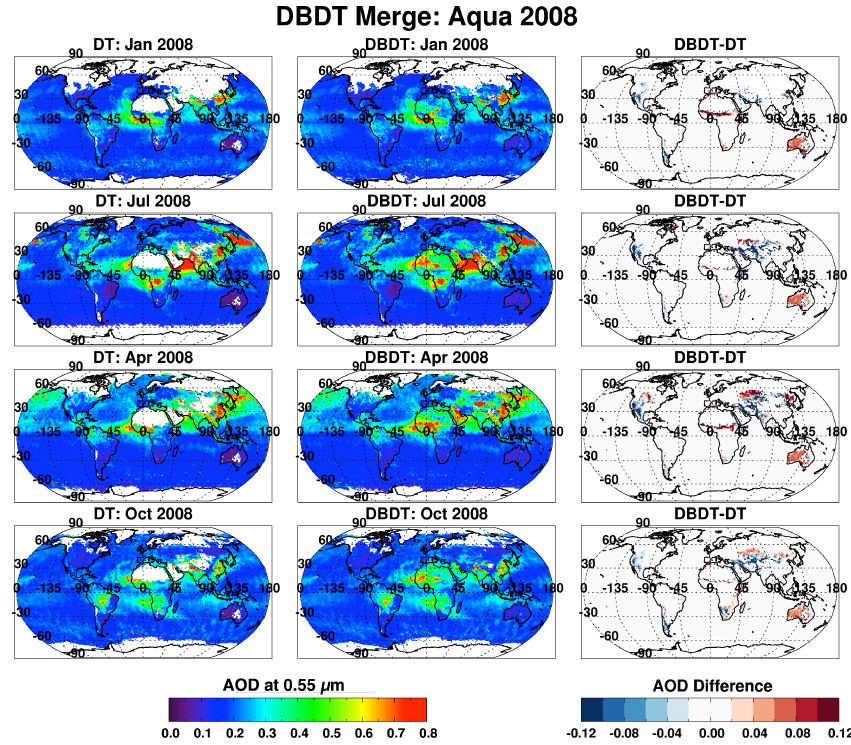
Figure 19: Global map of Aqua-derived AOD (at 0.55 µ m) for four months (Jan, Apr, Jul and Fig. 19. Global map of Aqua-derived AOD (at 0.55µm) for four months (January, April, July and October) in 2008. Plotted for each month Oct) in 2008. Plotted for each month are: DT only (left), merged DT/DB (center), and are: DT only (left), merged DT/DB (center), and differences between DBDT and DT, for grids where DT retrieves differences between DTDB and DT, for grids where DT retrieves (right).